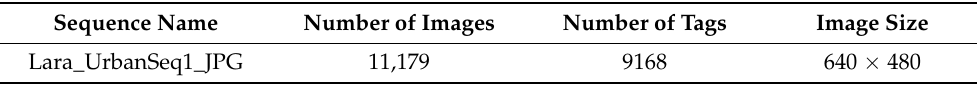
Table 4. Overview of the LaRa traffic light data